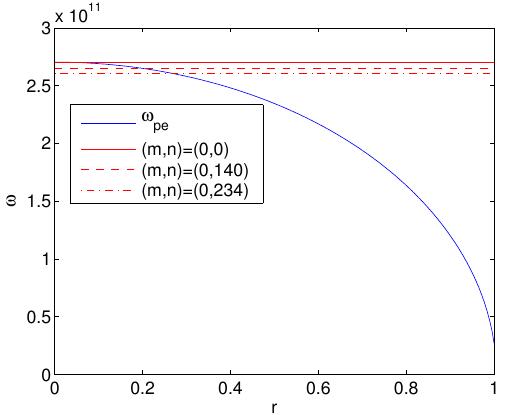
Figure 10: The comparison between ω pe and eigenmode frequency with ( m , n ) = (0 , 0) , (0 , 140) and (0 , 234) with respect to r